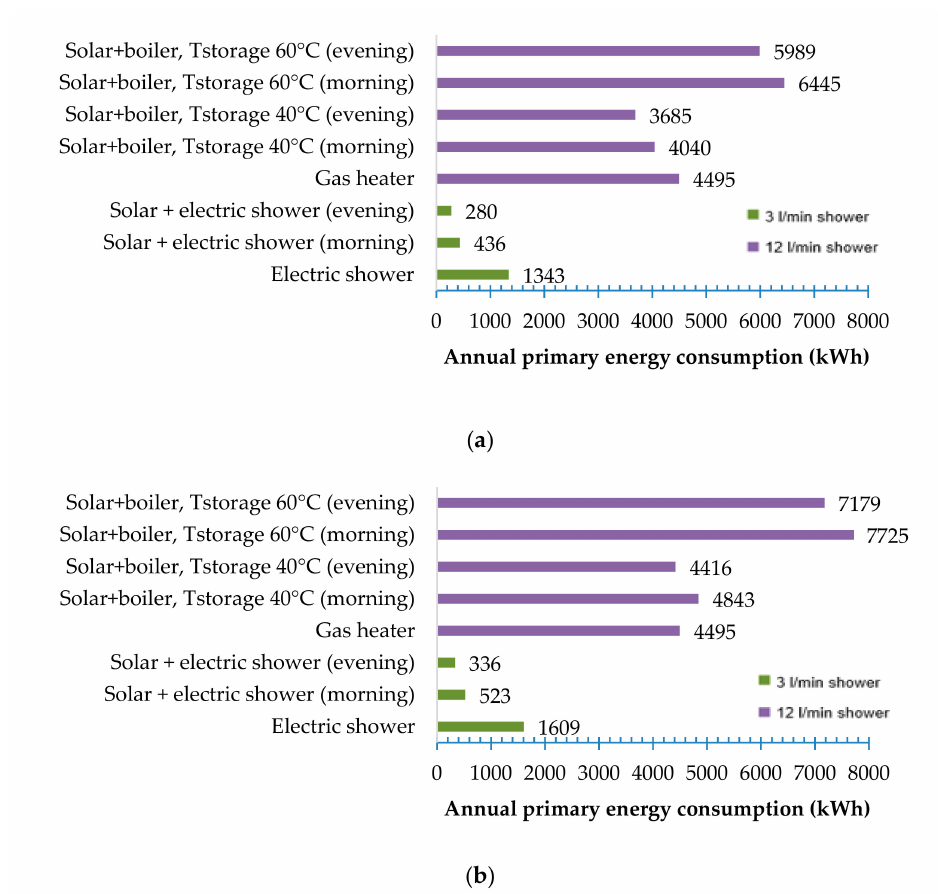
Figure 11. Annual primary energy consumption for water heating in Curitiba. ( a ) Current scenario; ( b ) critical